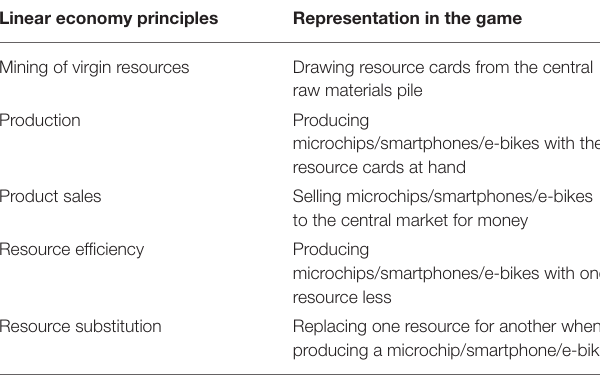
TABLE 2 | Linear economy strategies in the ecoCEO game.